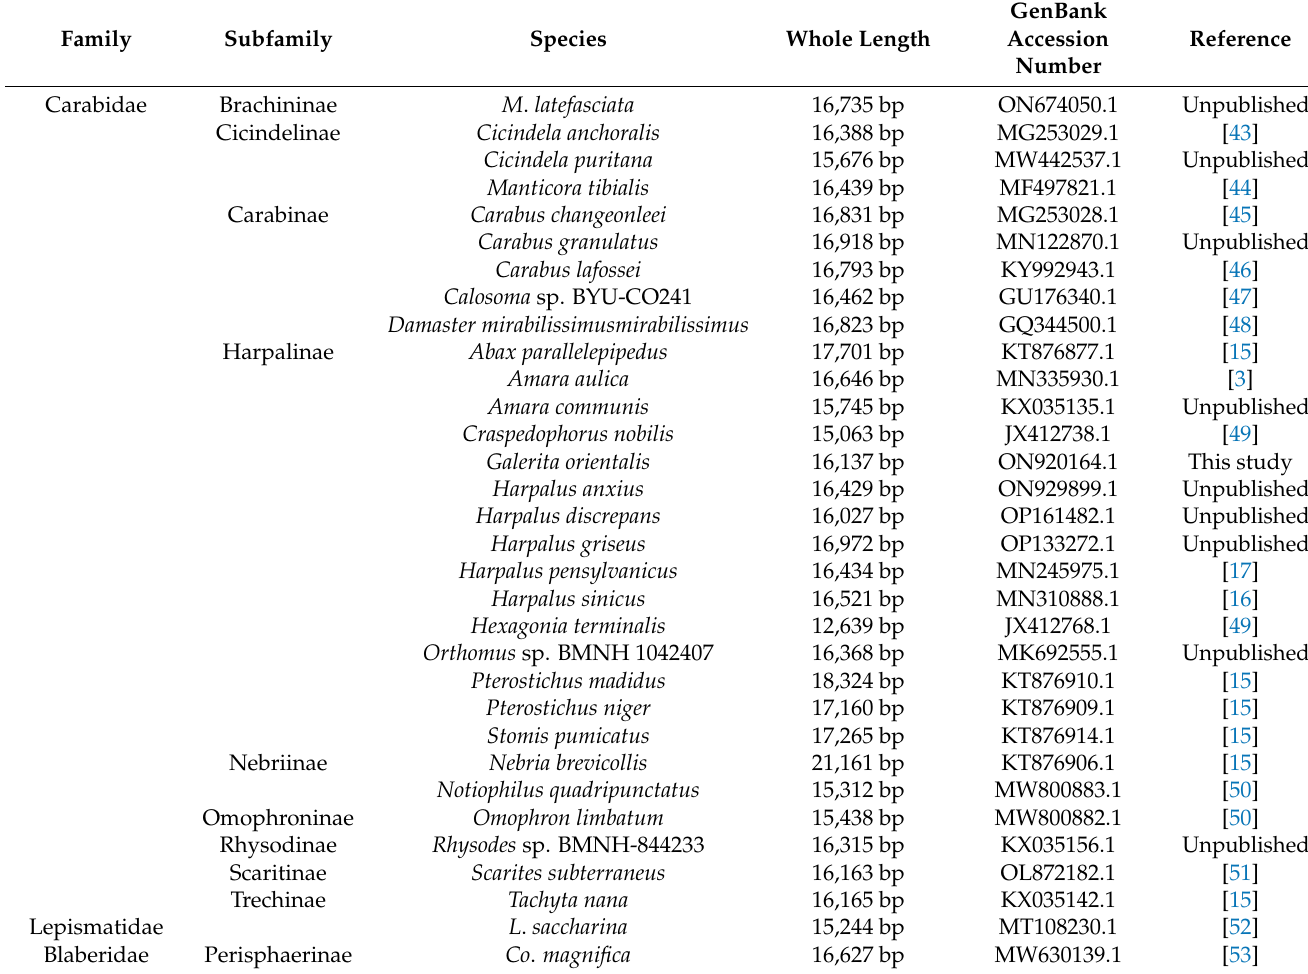
Table 1. The mitogenomic sequences used for phylogenetic analysis in this study.